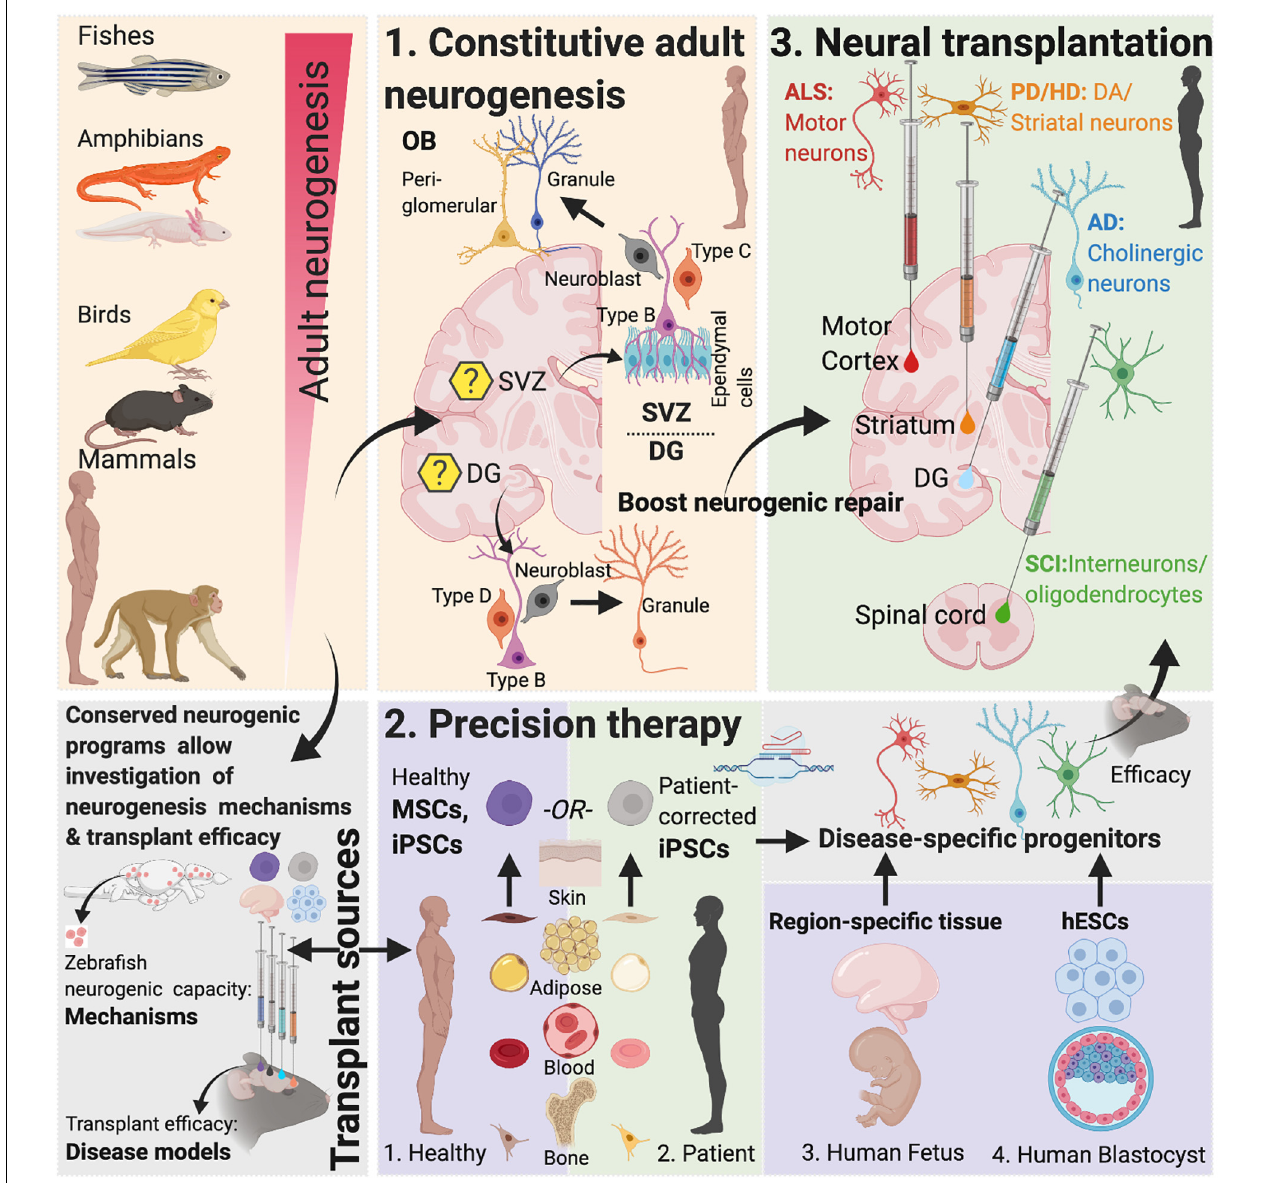
FIGURE 1 | Adult neurogenesis in mammals and non-mammals. Lessons from non-vertebrate neurogenesis and implications for designing cell-based transplant therapies. Mammalian SVZ Neurogenesis: Characterization of neurogenesis in the rodent SVZ has revealed the existence of quiescent and active populations of proliferating cells. While heterogenous populations of NSCs have been described, “type-B” cells maintaining close proximity with the ependymal cell layer include nestin-expressing populations that asymmetrically divide to form Ascli and Dlx2 expressing “type-C” cells, also called transit-amplifying cells, which then symmetrically divide to form Dcx-positive type-A neuroblasts. These neuroblasts constitute the rostral migratory stream (RMS) that eventually contributes to OB peri-glomerular and granule cells. Recent studies have suggested that “type-B” cells are derived from embryonic NSCs that also generate striatal, septal or cortical neurons and become quiescent between E13.5-15.5 until their activation in adulthood (Fuentealba et al., 2015). Within the OB, granule cells form > 95% of the adult-born population (Winner et al., 2002; Naritsuka et al., 2009; Merkle et al., 2014). Optogenetic activation paired with odor stimulation of adult-born neurons has been shown to facilitate difficult olfactory discrimination learning, an effect that is absent following photoactivation of early postnatal born neurons (Alonso et al., 2012). In addition, two photon-targeted recordings from peri-glomerular neurons have revealed that adult-born cells functionally integrate in the OB circuitry and whose activity is regulated by experience-dependent plasticity (Livneh et al., 2014). Mammalian DG Neurogenesis: Whether the adult mammalian hippocampus contains self-renewing NSCs or whether the neighboring lateral ventricular niche containing true NSCs maintains neurogenesis in the hippocampus has been contested (Seaberg and van der Kooy, 2002; Bull and Bartlett, 2005) but several recent studies have documented the presence of self-renewing, multipotent cells expressing embryonic NSC markers in the DG with fate mapping analysis confirming their stem cell behavior in vivo (Seri et al., 2001; Lagace et al., 2007; Imayoshi et al., 2008; Lugert et al., 2010; Bonaguidi et al., 2011; Encinas et al., 2011; Urban et al., 2016; Pilz et al., 2018). In the adult hippocampus (DG), SGZ radial glia-like cells give rise to proliferative non-radial-like populations that differentiate into neuroblasts. Upon differentiation, these neuroblasts develop into granule cells (Pilz et al., 2018). The embryonic origin of adult precursors in the DG in rodents was recently traced to a common Hopx-positive precursor population that is responsible for